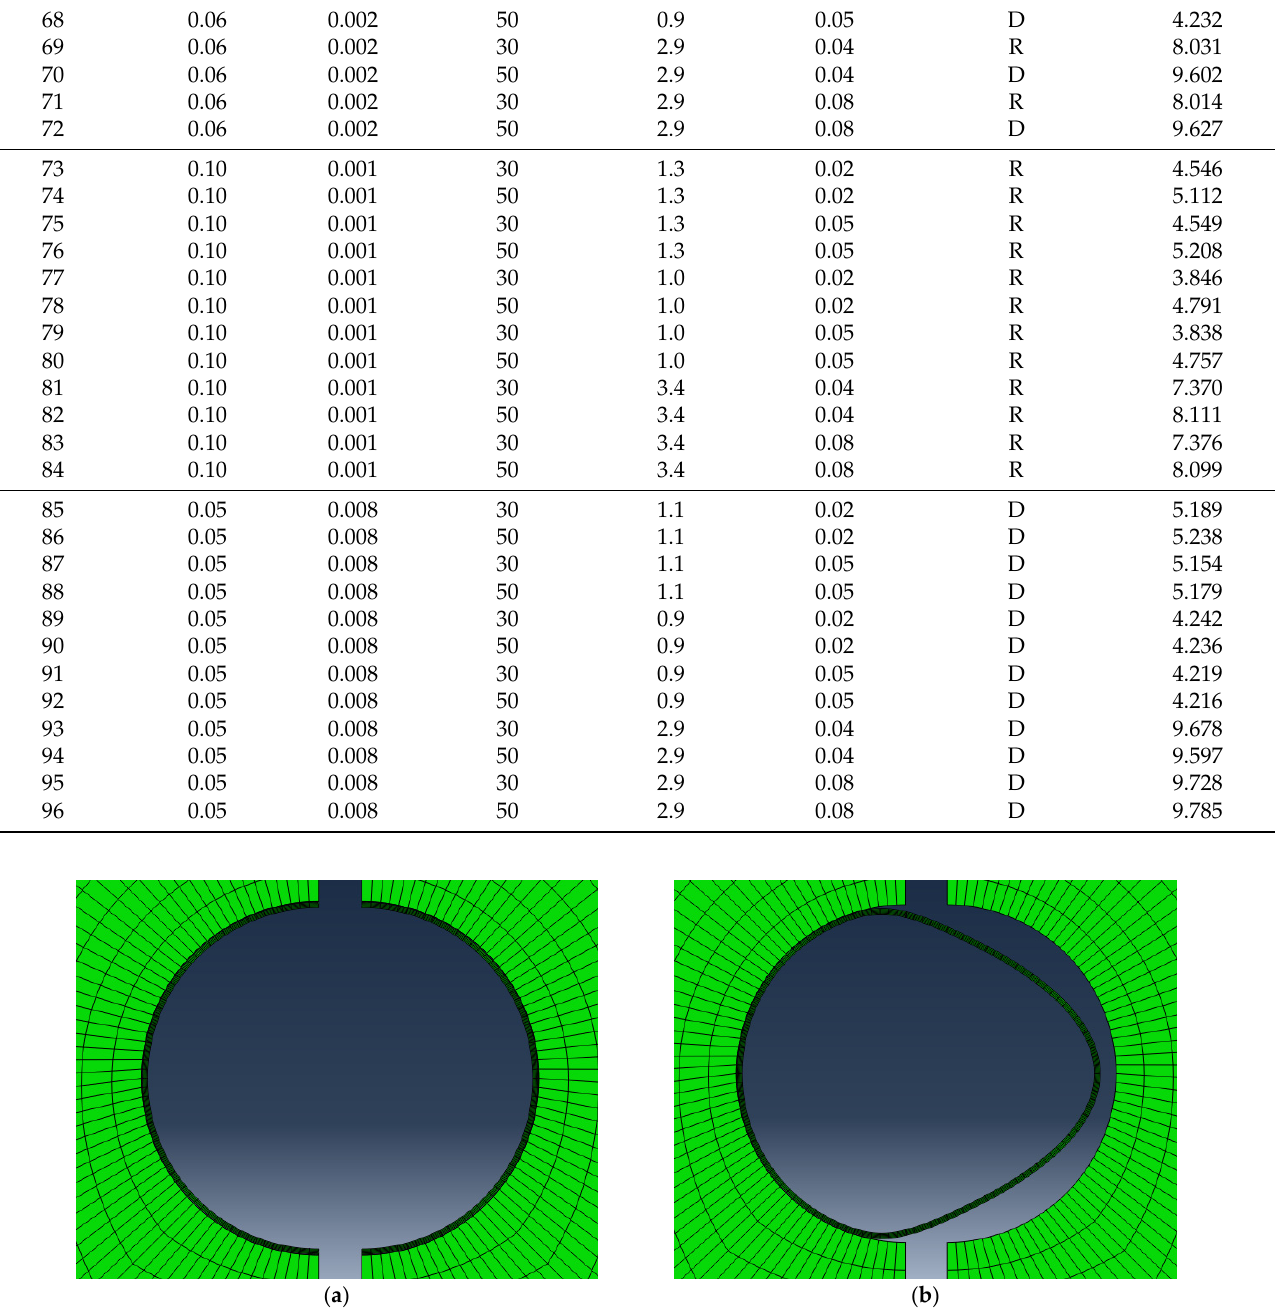
Figure 4. Capsule failure modes: ( a ) rupturing, ( b ) debonding.